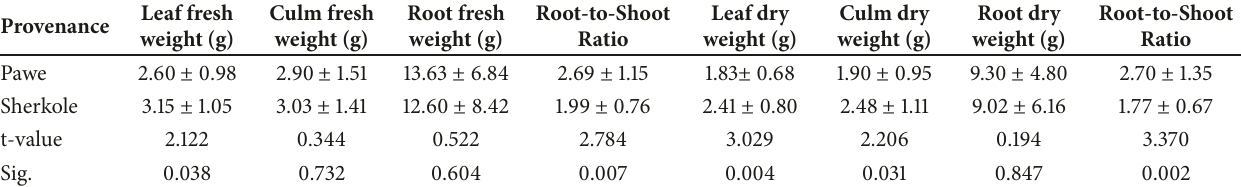
Table 4: Mean values of seedlings Biomass estimation between two O. abyssinica provenances (n=30, mean ± SD).